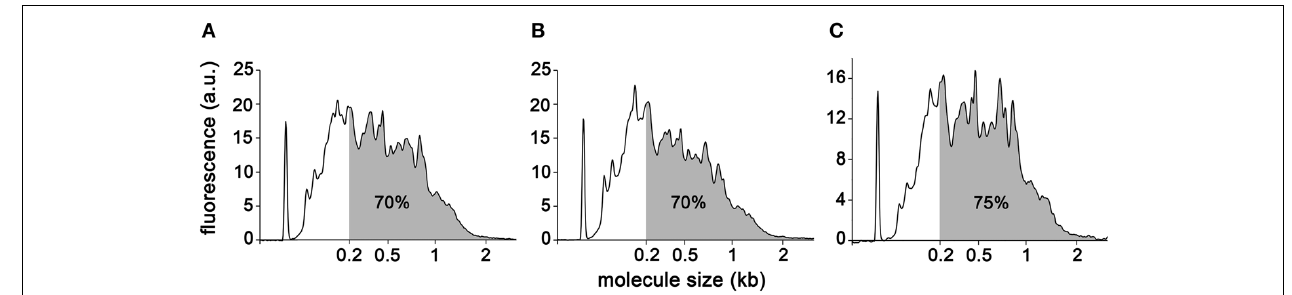
FIGURE 4 | BioAnalyzer traces of amplified cDNAs. A-type (A) , B-type (B) , and UA-type (C) cells. Percentage of DNA molecules greater than 200 nucleotides is indicated.